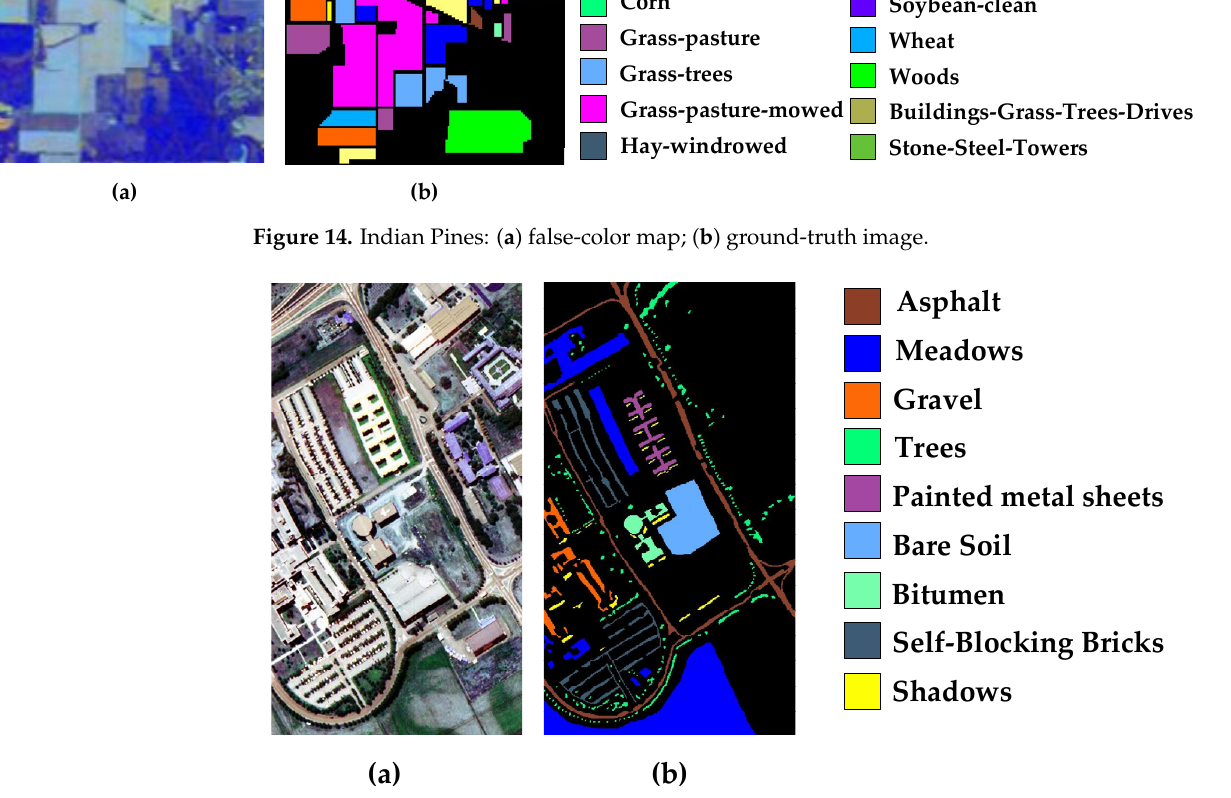
Figure 15. University of Pavia: ( a ) false-color map; ( b ) ground-truth image. Table 2. Number of training, validation, and testing samples for the UP dataset.